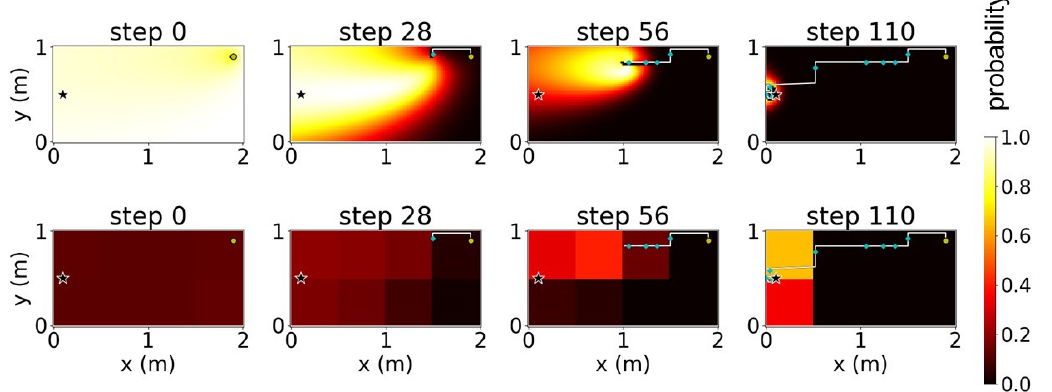
Figure 10. Timeline of a search using environment decomposition with the number of sub- environments ( K ) = 8 and stand-out coefficient ( ρ ) = 4. The star indicates odor source location.